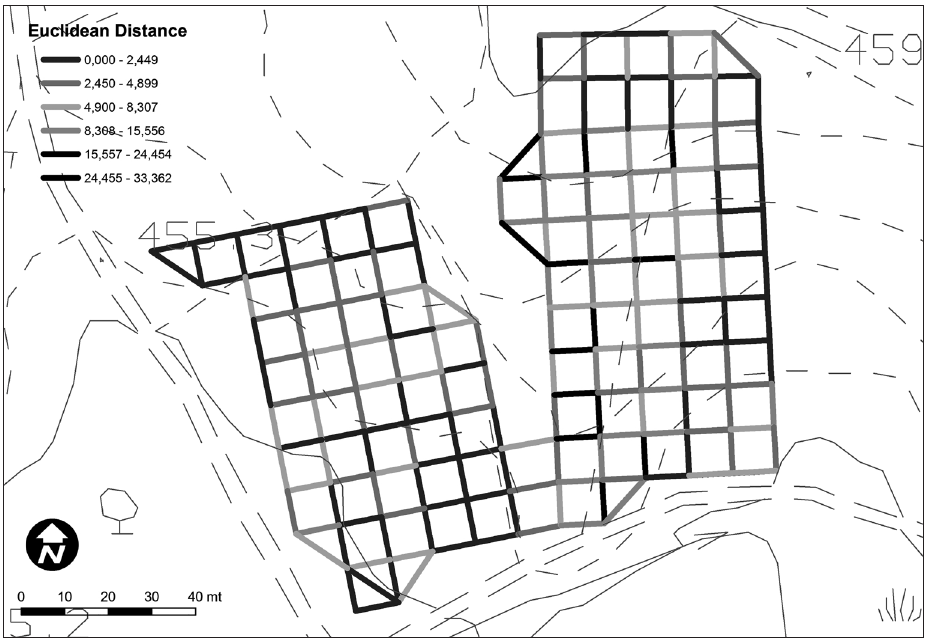
Figure 3: Euclidean distance expressed as a cartogram to represent assemblage variability in A119